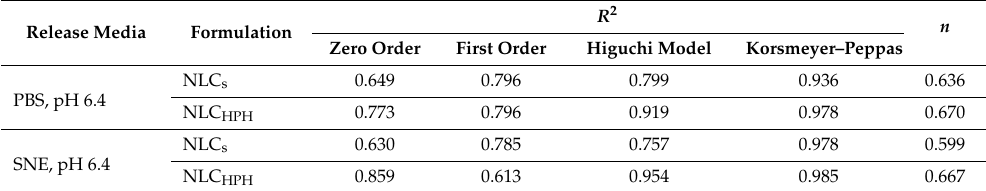
Table 6. Results of the curve fitting into di ff erent kinetic models for rivastigmine-loaded nanostructured lipid carriers (NLC) formulations prepared by ultrasound technique and high-pressure homogenization (HPH)